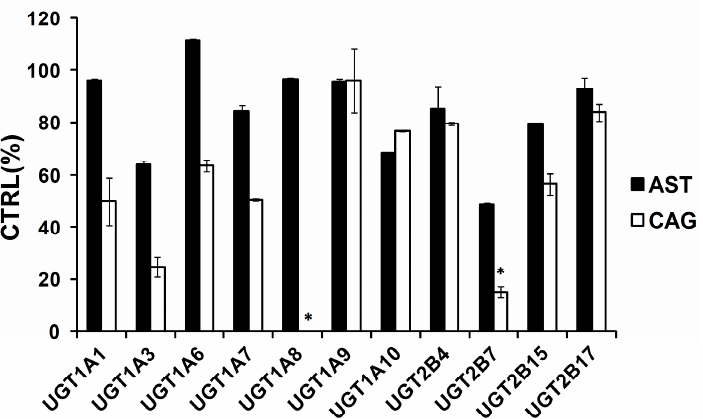
Figure 2. Screening the inhibition of UGT isoforms by 100 μ M AST and CAG. 4-methylumbelliferone (4-MU) was used as a probe substrate for recombinant human UGT1A1, UGT1A3, UGT1A6, UGT1A7, UGT1A8, UGT1A9, UGT1A10, UGT2B4, UGT2B7, UGT2B15, and UGT2B17, and data are shown using mean value plus SD. * p < 0.05.